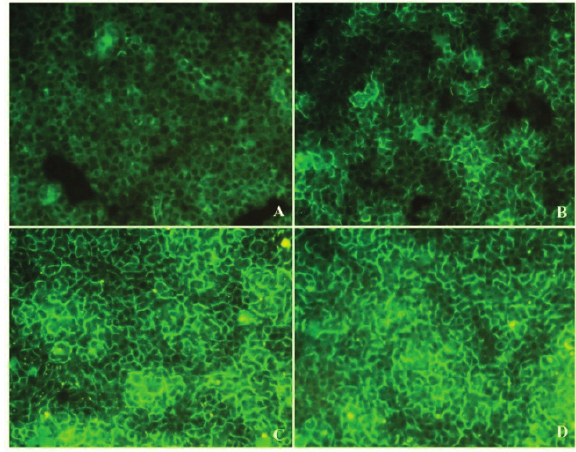
Figure 5. Calreticulin (CRT) exposure detected by immunofluoroscence assay after treatment of X12-PG. ( A – D ) were respectively treated with 0, 400, 800, 1600 μ g/mL X12-PG for 48 h, then incubated with primary antibody (Anti-Calreticulin, diluted 1:200 in blocking buffer) and detected with the FITC-labeled secondary antibody. Fluorescence intensity was visualized by immunofluorescence microscopy